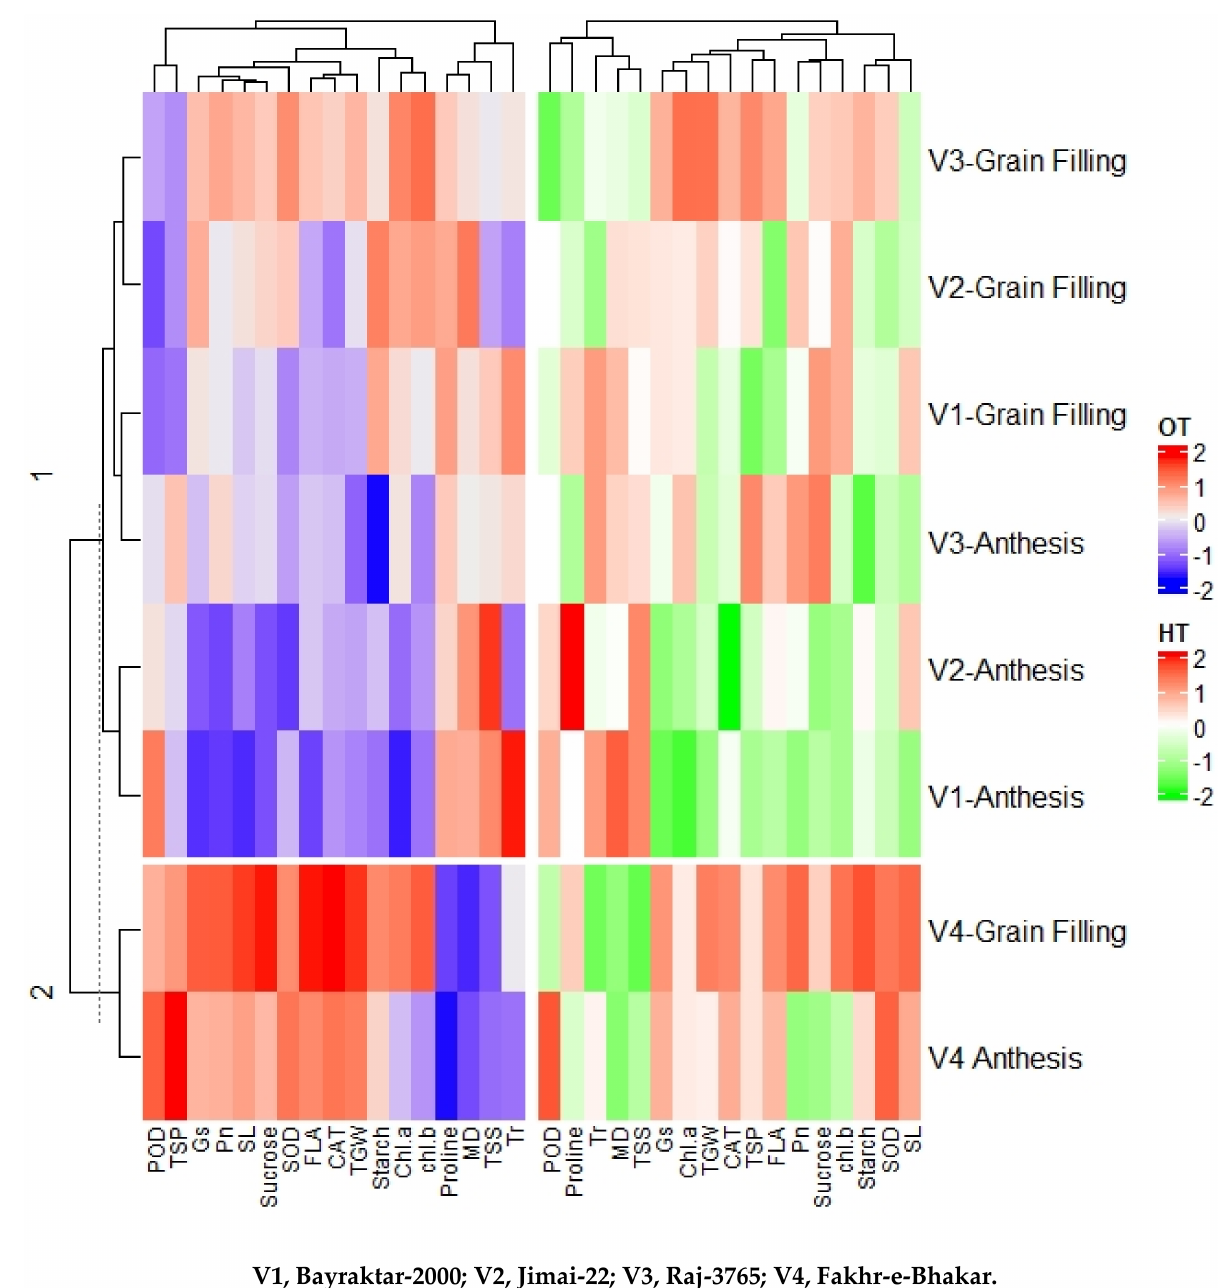
Figure 11. Cluster heat map analysis summarizing the responses of osmolytes, physiological parameters, antioxidants and agronomic traits to genotypes at anthesis and grain-filling stages under optimum (OT) and high temperature (HT) regimes. The colour bands reveal the differential association of traits: TSS, total soluble sugar; TSP, total soluble proteins; Gs, stomatal conductance; Tr, transpiration rate; MD, membrane damage; Pn, photosynthesis rate; SOD, superoxide dismutase; CAT, catalase; POD, peroxidase; FLA, flag leaf area; SL, spike length; TGW, thousand grain